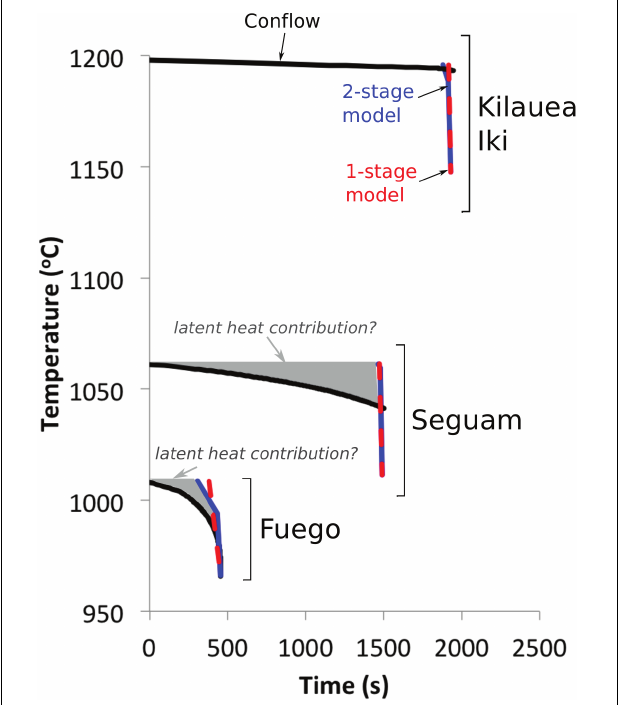
FIGURE 8 | Thermal histories of syneruptive magmas from Fuego, Seguam, and Kilauea Iki, as determined by fitting melt inclusion MgO concentration gradients to one-stage (red dashed lines) and two-stage (blue lines) cooling models, and as calculated by the ‘Conflow’ model (Mastin and Ghiorso, 2000; Campagnola et al., 2016) (black curves). At Kilauea Iki, the Conflow model suggests that the magma cooled very little during ascent through the conduit. We interpret the ∼ 10 s of cooling recorded by the inclusions to represent quenching in the fire-fountain. At Seguam and Fuego, we do not find good agreement between our inclusion-derived thermal histories and the Conflow calculation: Conflow predicts 20–40 ◦ C of magma cooling during ascent, while the MgO concentrations in the centers of our Seguam and Fuego inclusions are approximately in equilibrium with their olivine hosts, which suggests that they did not experience net cooling during ascent. One- and two-stage cooling model parameters are averages of parameters obtained by fitting individual melt inclusions from a given eruption (see Supplementary Data Tables ). Values of input parameters for the Conflow model curves (e.g., initial ascent velocity, initial pressure and magma composition) are provided in the Supplementary Data Tables . Initial ascent velocities for Seguam and Kilauea Iki are based on ascent histories derived from volatile concentration gradients along melt embayments; the choice of initial velocity and initial pressure determines the duration of the calculated ascent history for each of these eruptions. For the subplinian Fuego eruption, we assume that the magma reaches sonic velocity at the surface (i.e., the theoretical maximum velocity). Application of this assumption for the Conflow calculation results in magma ascent velocities that are comparable to those obtained by fitting volatile concentration gradients in melt embayments (Lloyd et al.,